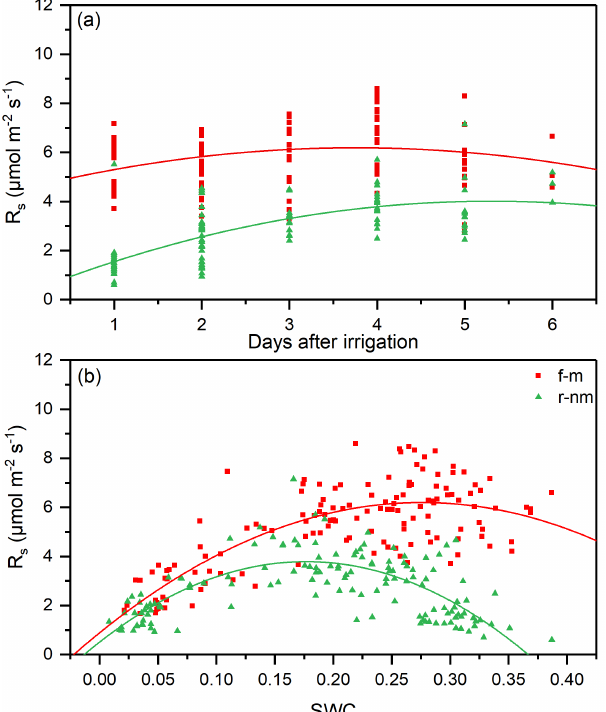
Figure 7. Influence of irrigation on soil respiration. (a) Variation in soil respiration with number of days after irrigation. (b) Relation between soil respiration and soil moisture (regression lines are fitted with the binomial equation in Eq. (6) (f-m and r-nm represent the furrow in the mulched field and the ridge in the non-mulched field,